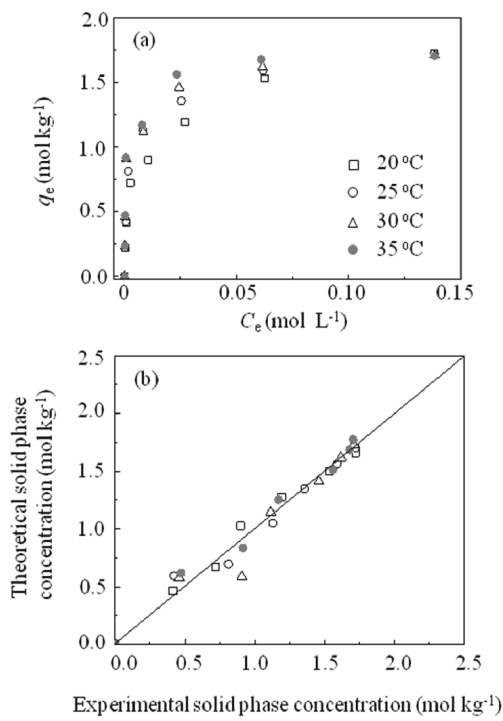
Fig. 5 – Experimental and the theoretically predicted ad- sorption isotherms of D-GA at varying temperatures (a) exper- imental points (b) reproducibility of the experimental data by the theoretical